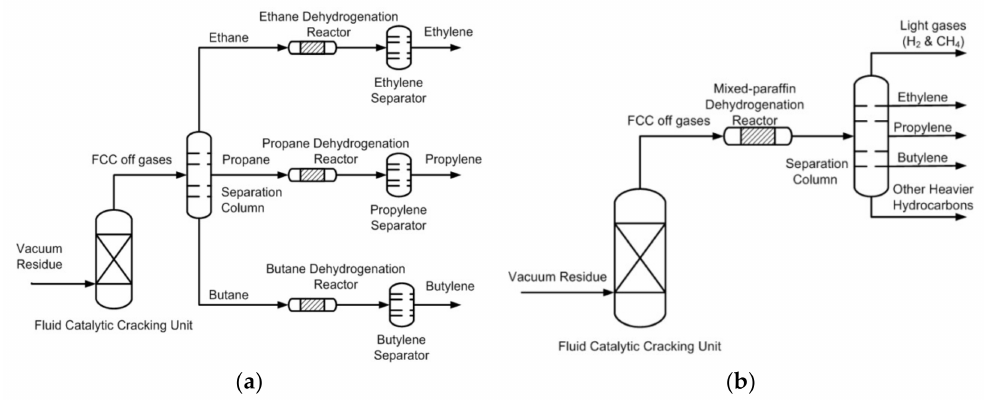
Figure 1. Block diagram of the ( a ) current dehydrogenation process and ( b ) proposed dehydrogenation process. FCC, fluid catalytic